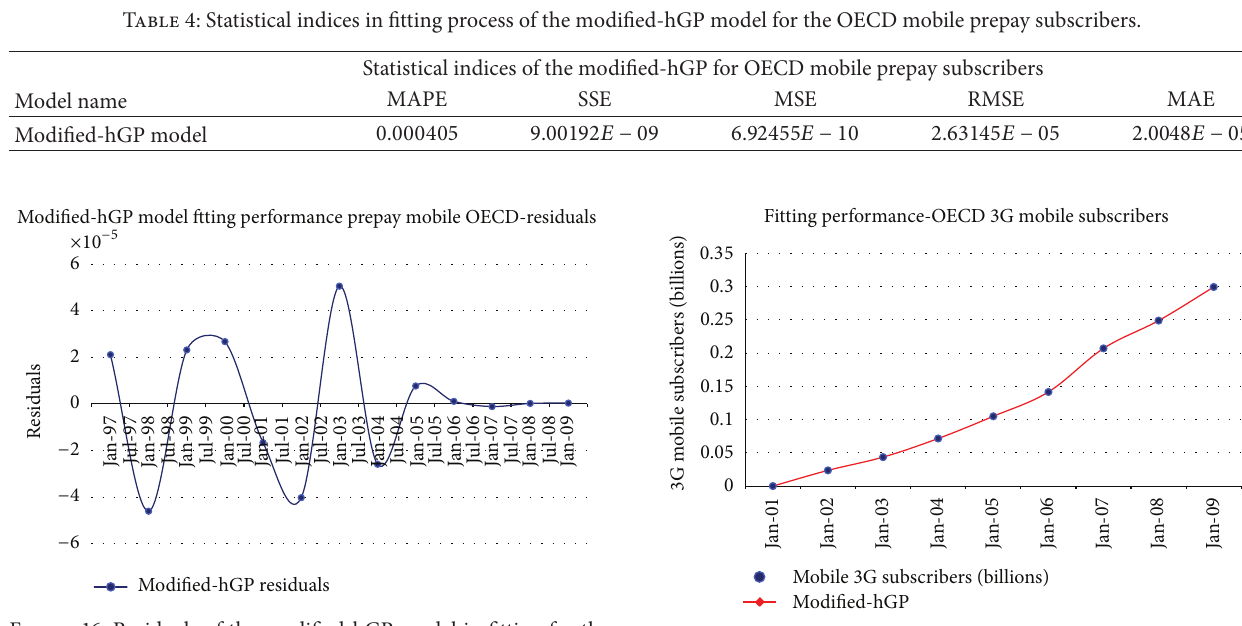
Figure 16: Residuals of the modified-hGP model in fitting for the OECD mobile prepay subscribers. Figure 17: The fitting performance of the modified-hGP model for the OECD 3G mobile subscribers.